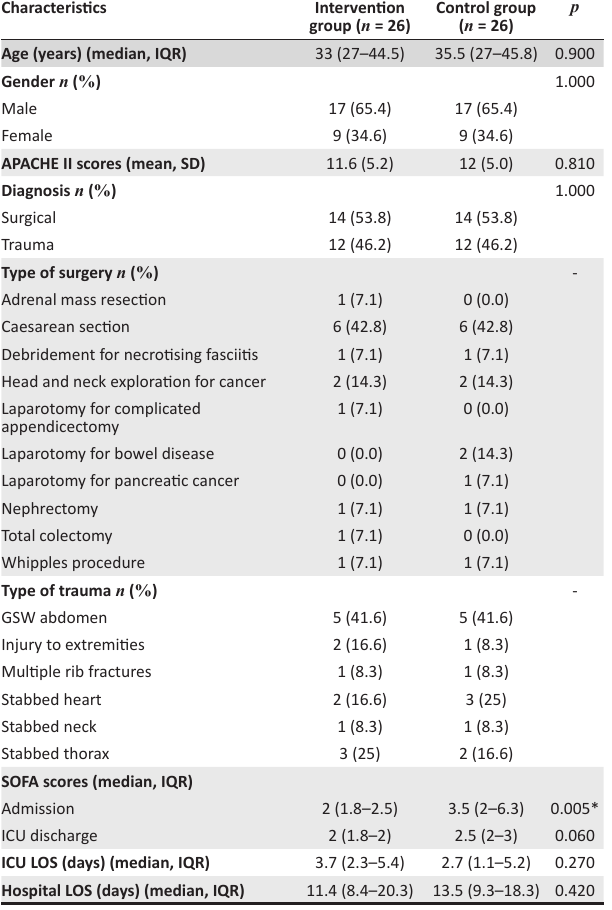
TABLE 1: Characteristics of study participants.